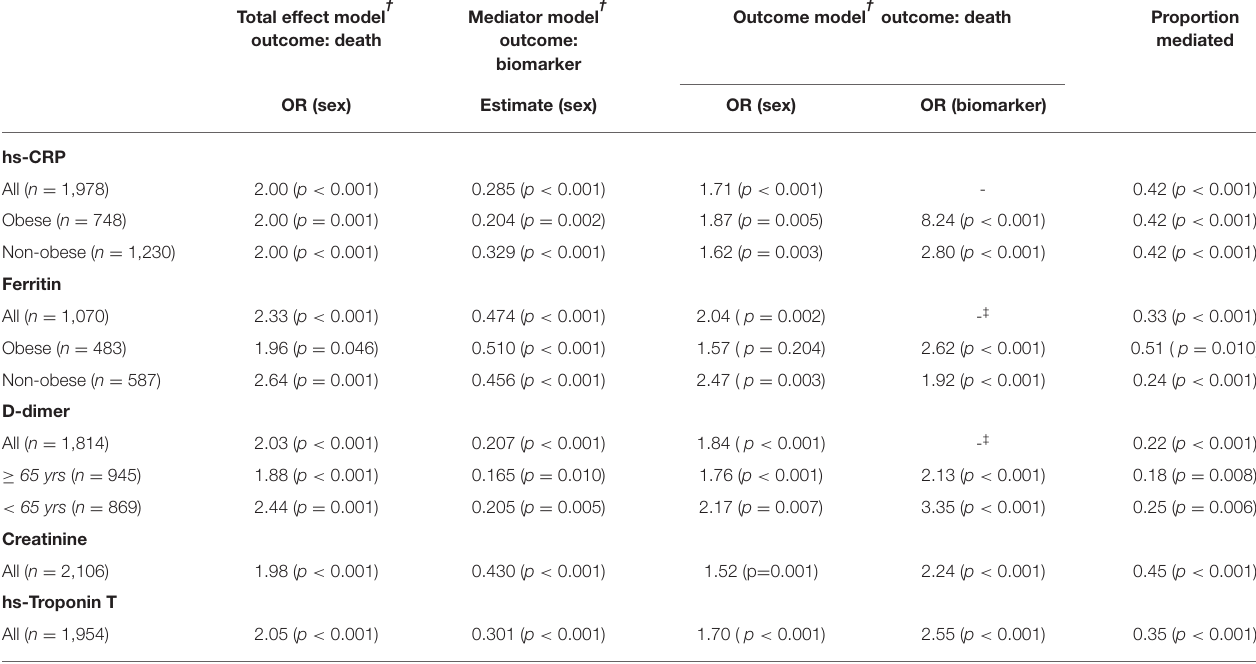
TABLE 3 | Primary mediation analyses of peak values* of biomarkers in CUIMC/NYP COVID-19